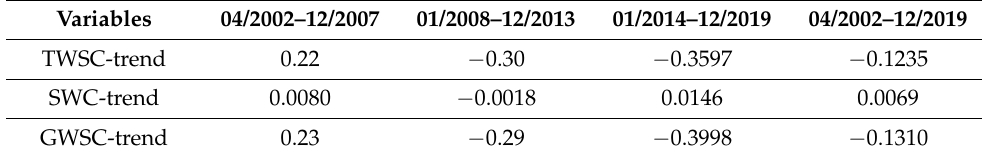
Table 1. Trends of TWSC, SWC, and GWSC.